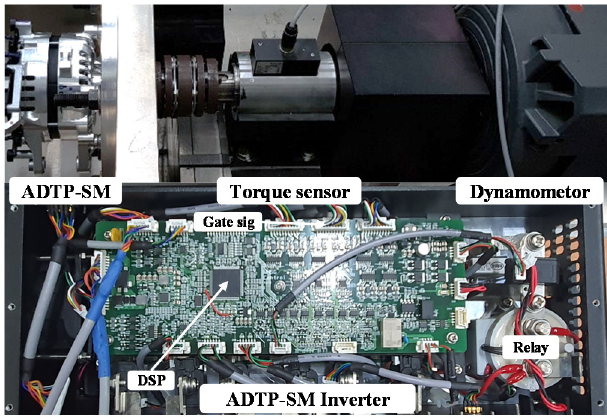
Figure 7. Picture of the experimental setup.